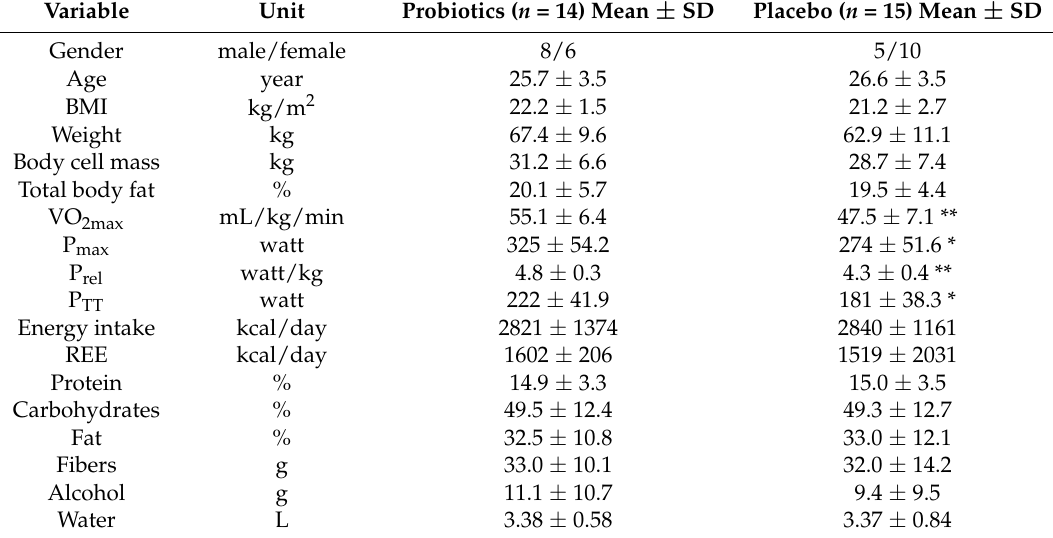
Table 1. Baseline characteristics, nutrition and performance data of the